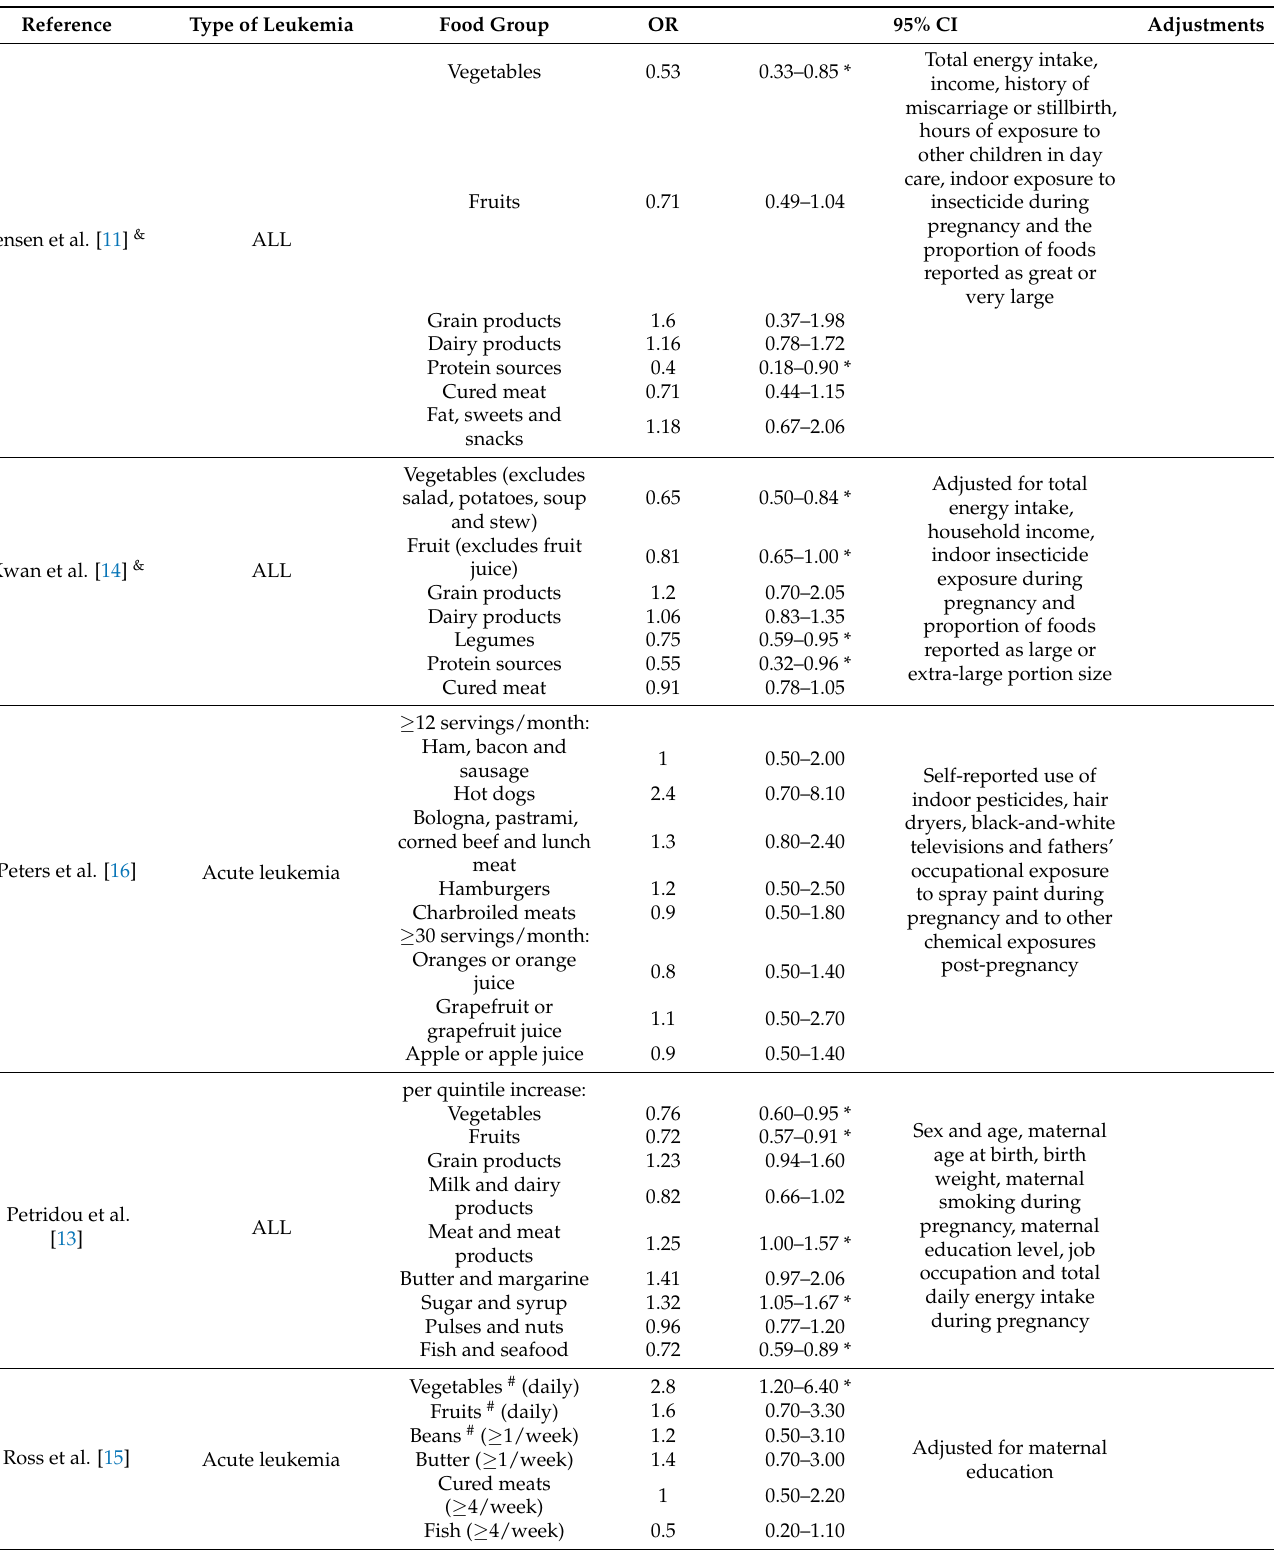
Table 5. Overview of the association between maternal food group intake during pregnancy (if not specified) and the risk of acute leukemia in